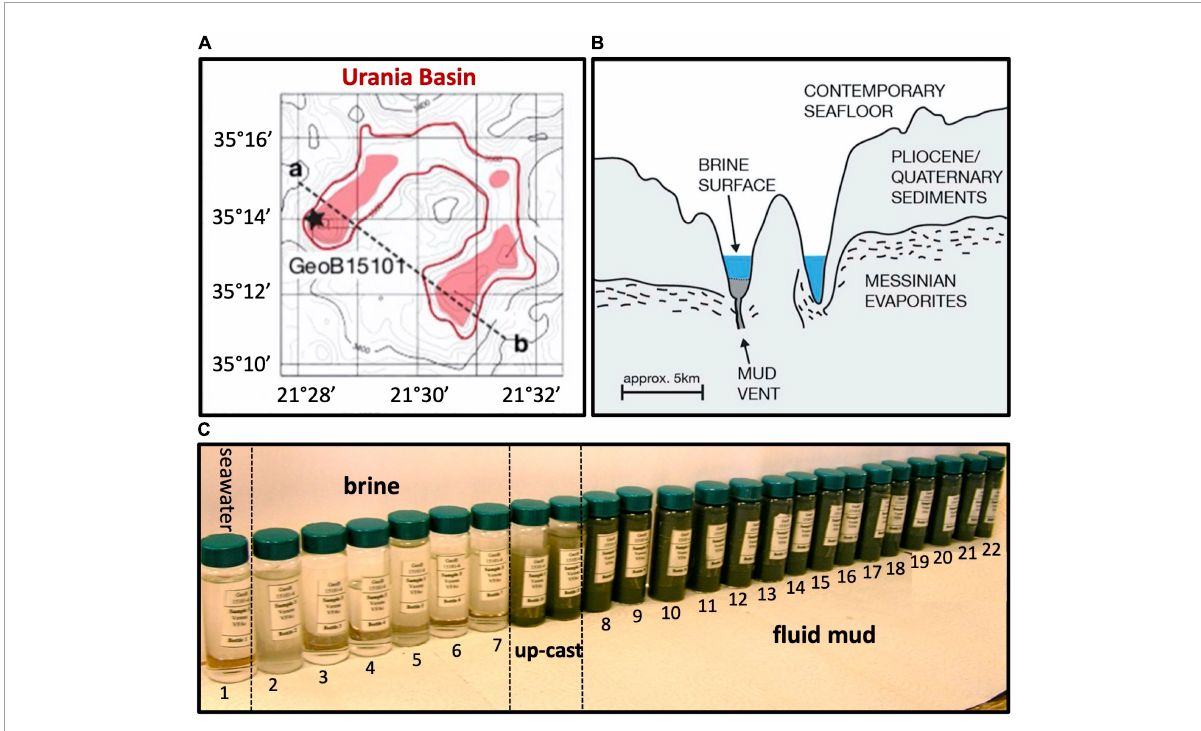
FIGURE1 (A) Lower left, bathymetry of Urania Basin with bottom brines highlighted in red, and profile line drawn from the mud volcano in the northwestern end toward the southeastern end of Urania Basin. (B) Geologic sketch of Urania Basin, following the profile line between points a and b. (C) Sample vials with Niskin bottle samples from seawater, brine, and fluidized mud. The samples between brine and mud layer represent perturbed samples from the CTD upcast (GeoB15101-6, Zabel, 2012) at 3,605 and 3,610 m depth. All figure panels modified from Aiello et al.